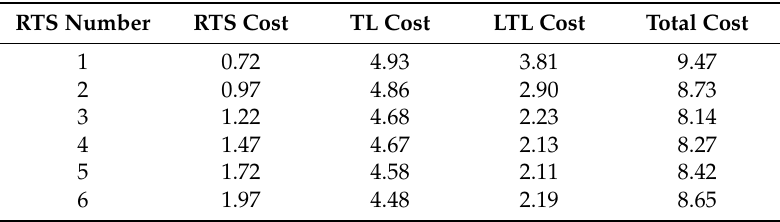
Table 1. Annual operation costs under different scenarios (unit: million